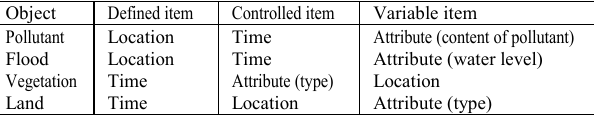
Table 1. Traditional time expression